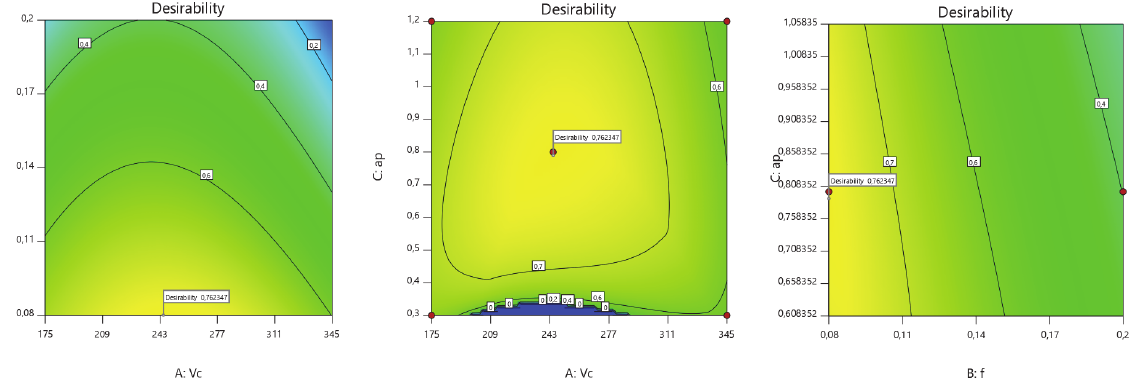
Fig. 30. Desirability contours graphs of optimization